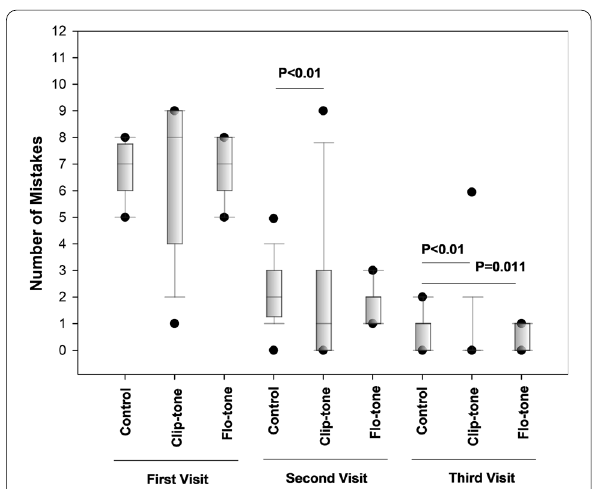
Fig. 3 Comparing medians of number of mistakes of different interventions per visit